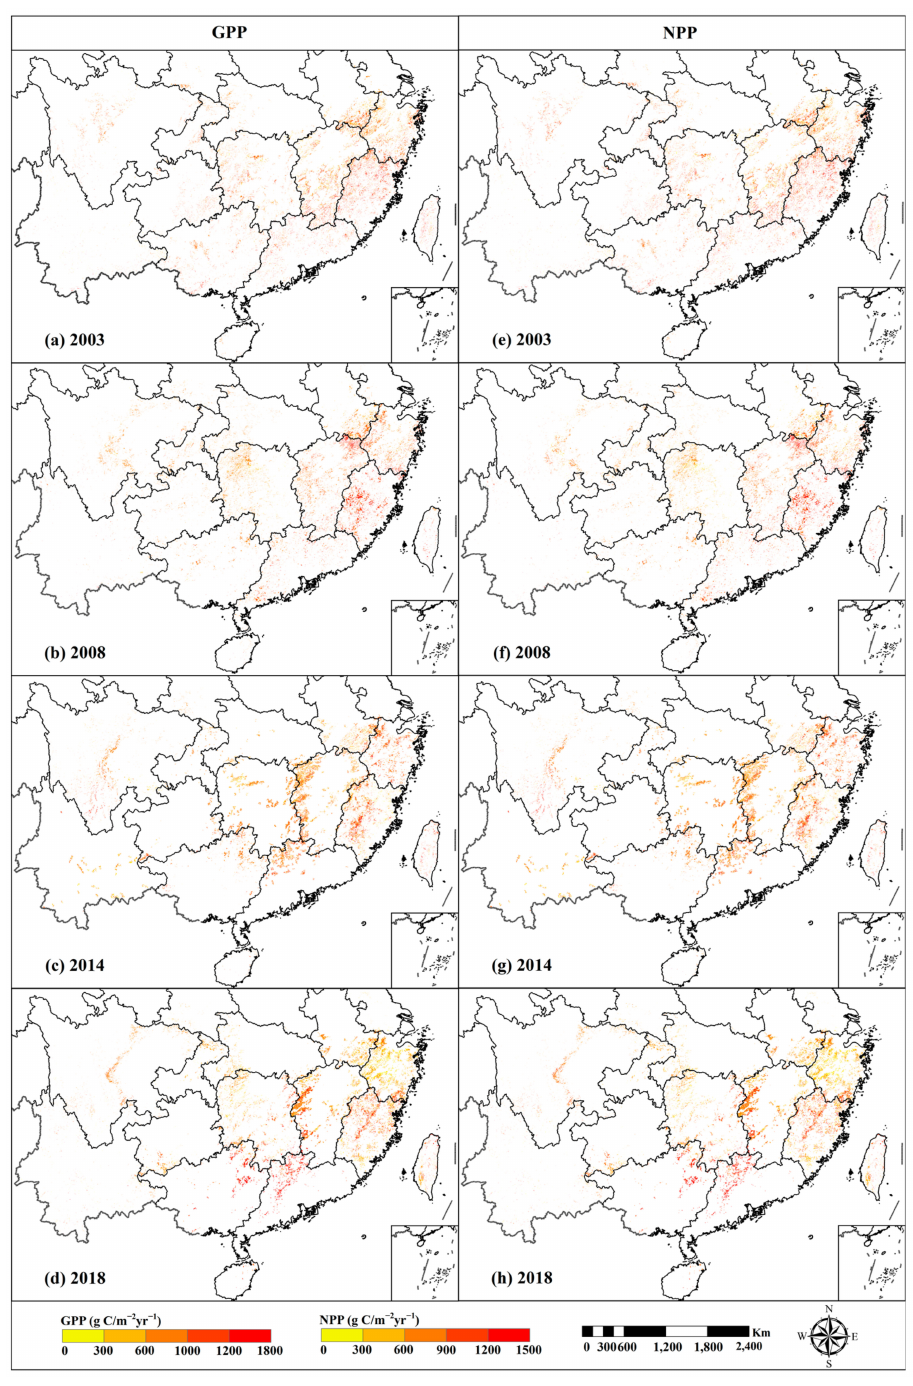
Figure 6. Spatial distribution of ( a – d ) GPP and ( e – h ) NPP of bamboo forests in China during different